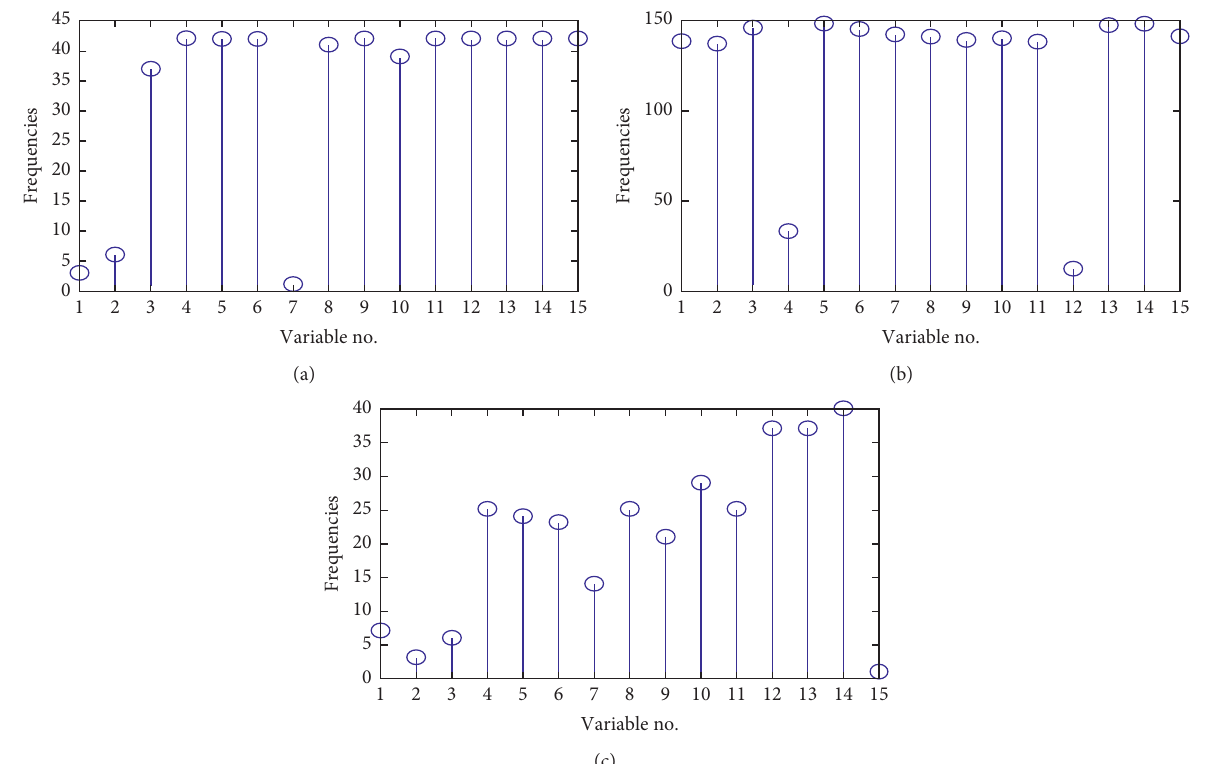
Figure 9: Out-of-limit number (OLN) variation of various dimensional data with (a) anomaly A, (b) anomaly B, and (c) anomaly